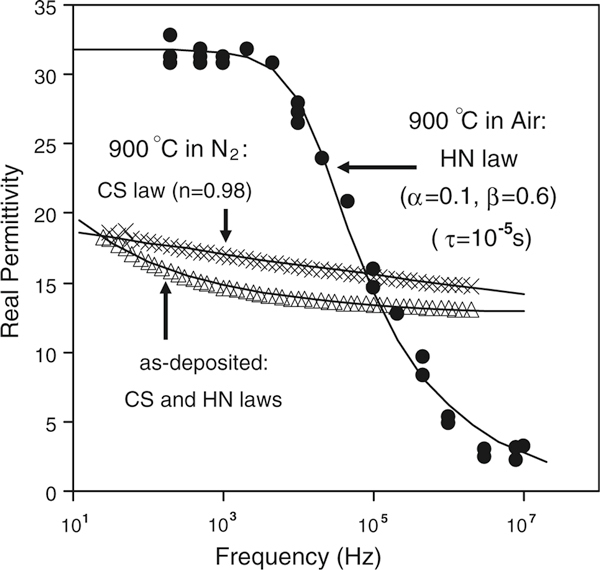
Frequency dependence of k-value of La0.35Zr0.65O2 dielectric for as-deposited and PDA samples. Significant dielectric relaxation was observed in the air-annealed sample. Solid lines are the fitting results using equations (1) and (2).